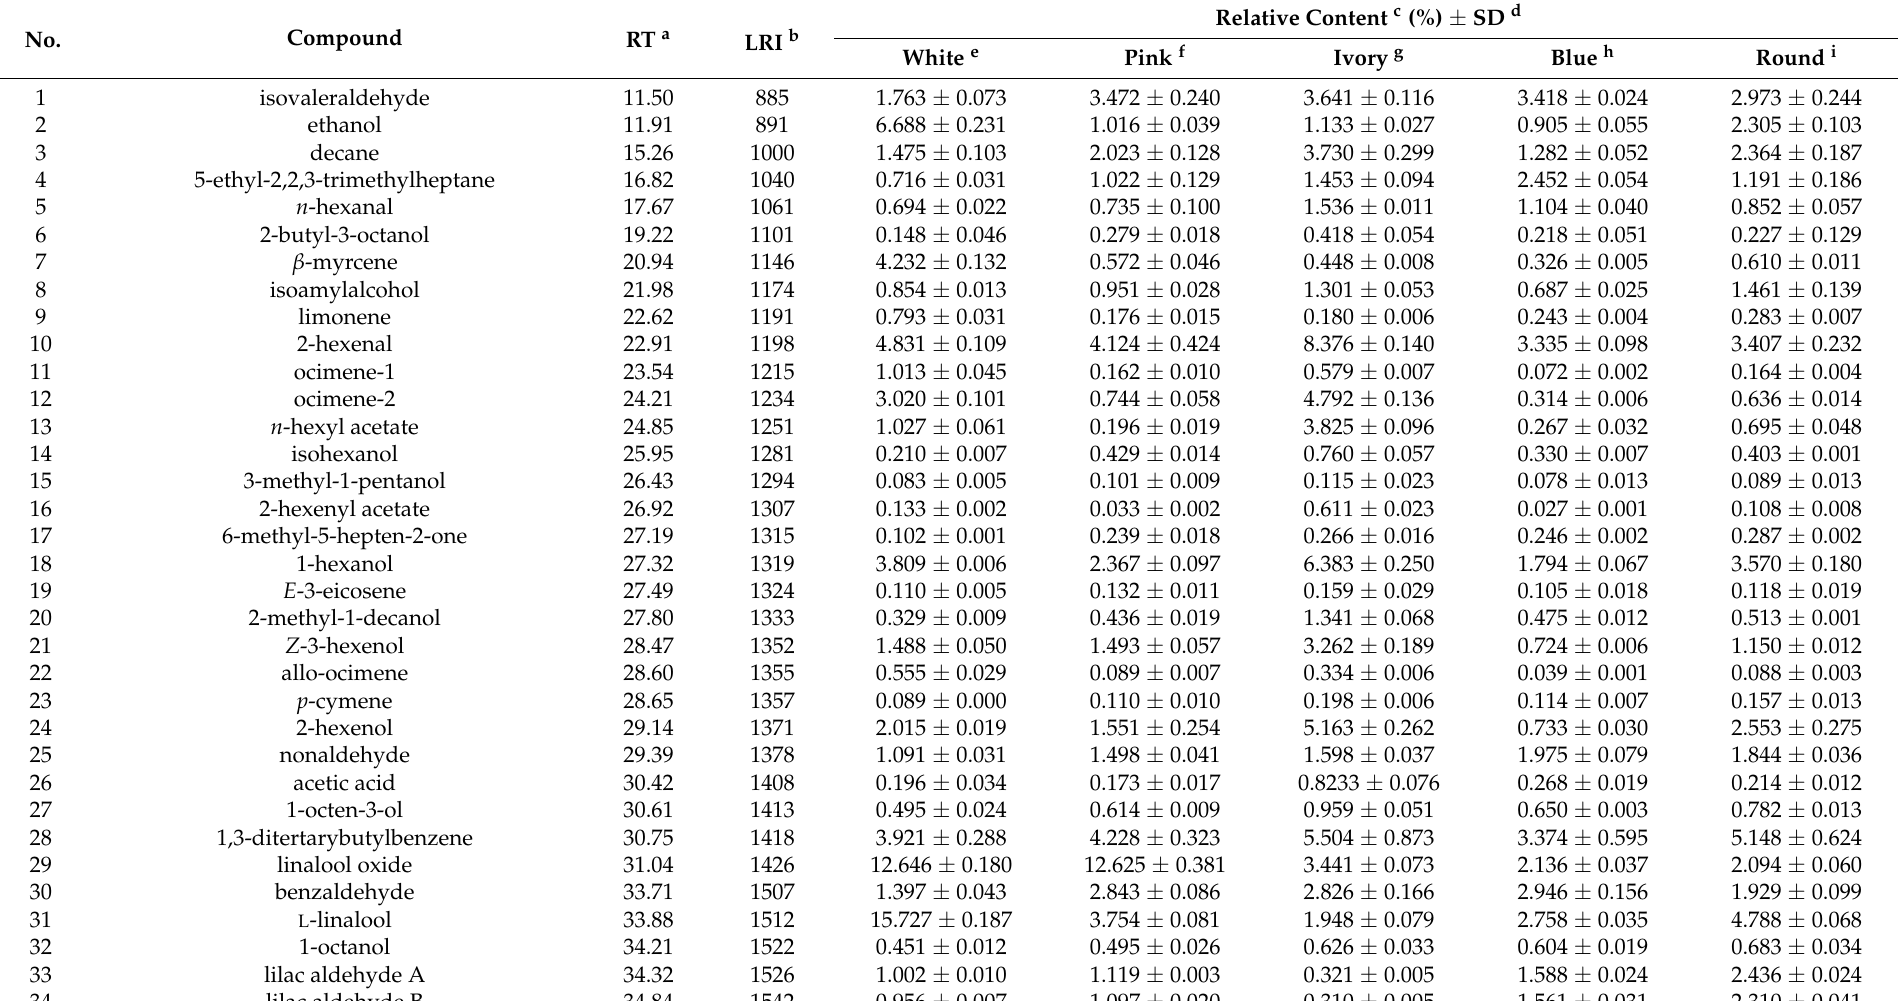
Table 1. Relative contents of the detected volatile components of fresh petal tissue in five variants of Abeliophyllum distichum flowers using headspace solid-phase microextraction gas chromatography–mass spectrometry (HS-SPME-GC-MS)